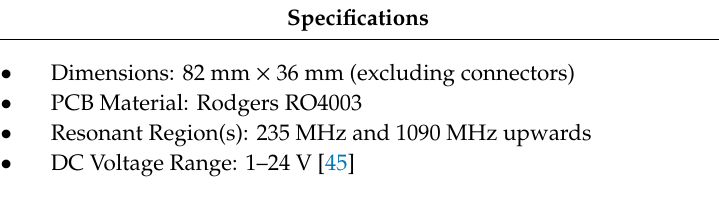
Table 2. Sensor design specifications.